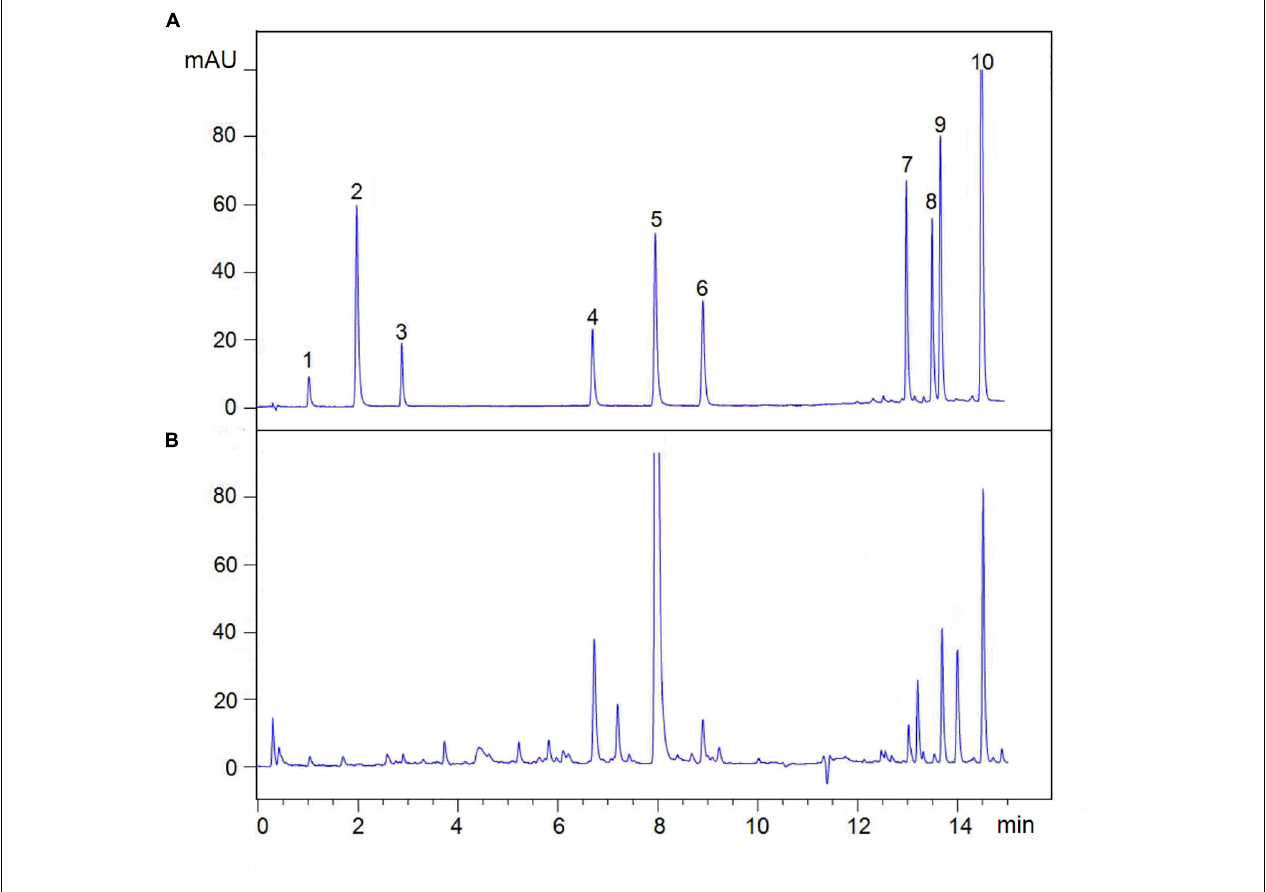
FIGURE 2 | Typical UPLC chromatograms of (A) mixed standards and (B) sample. (1) Sodium danshensu, DS; (2) Protocatechuic aldehyde; (3) Caffeic acid, CA; (4) Rosmarinic acid, RA; (5) Salvianolic acid B, Sal B; (6) Salvianolic acid A, Sal A; (7) Dihydrotanshinone I, DT-I; (8) Tanshinone I, TS-I; (9) Cryptotanshinone, CT; (10) Tanshinone IA, TS-IIA.